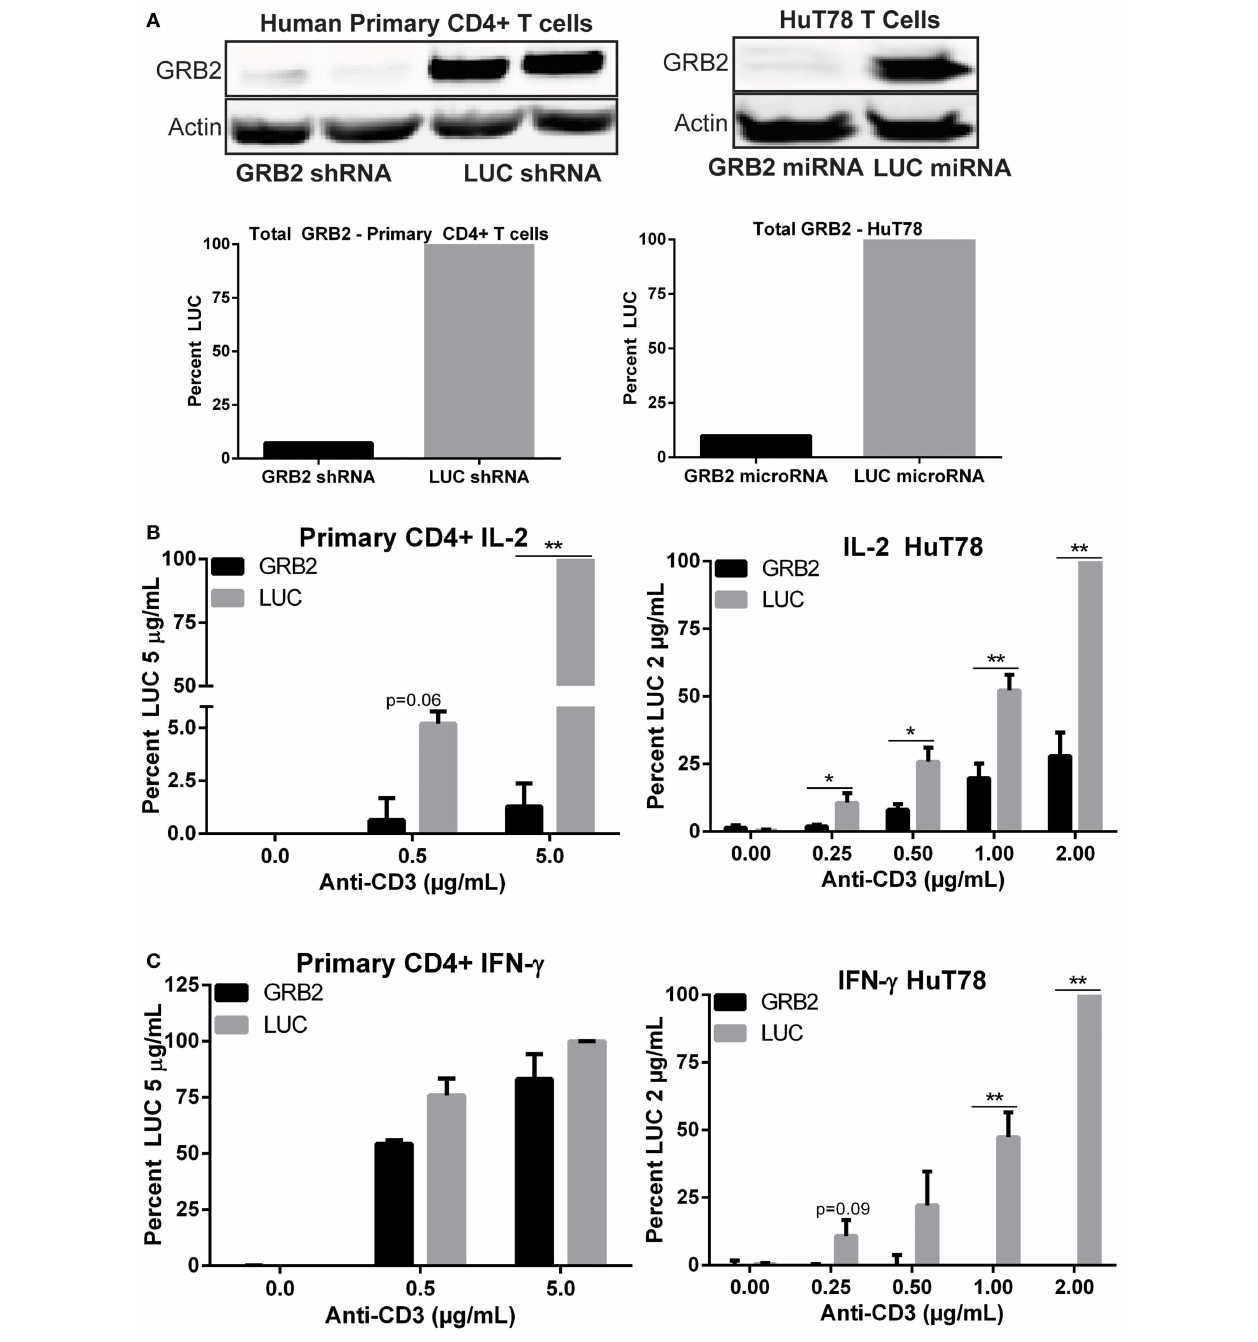
and HuT78T cells. (B,C) IL-2 and IFN- γ production in GRB2 deficient and LUC HuT78T cells orYFP + primary human CD4 + T cells stimulated with plate bound anti-CD3 for 24h.The mean normalized value ± SEM of seven independent experiments (HuT78T cells) or three different donors (primary CD4 + T cells) is